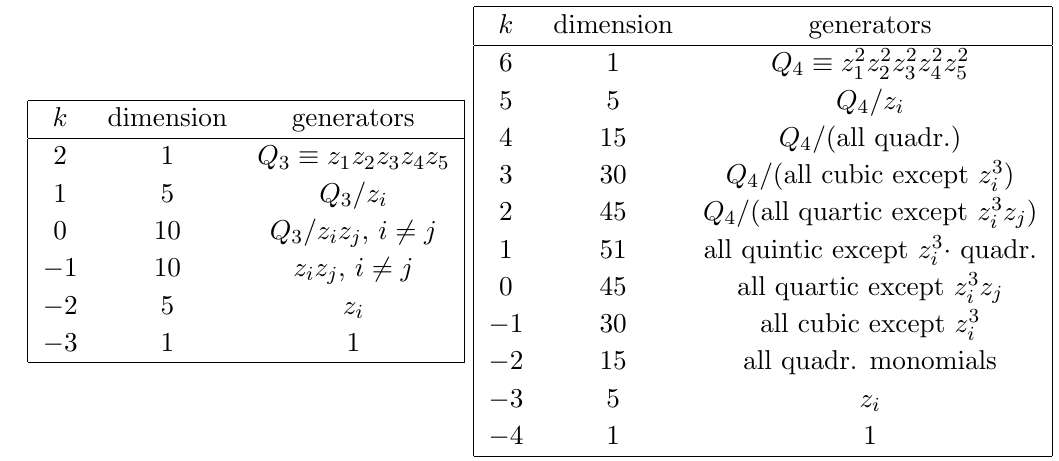
Table 1 . Dimension and generators of H 1 ( M d = 3; right, d =